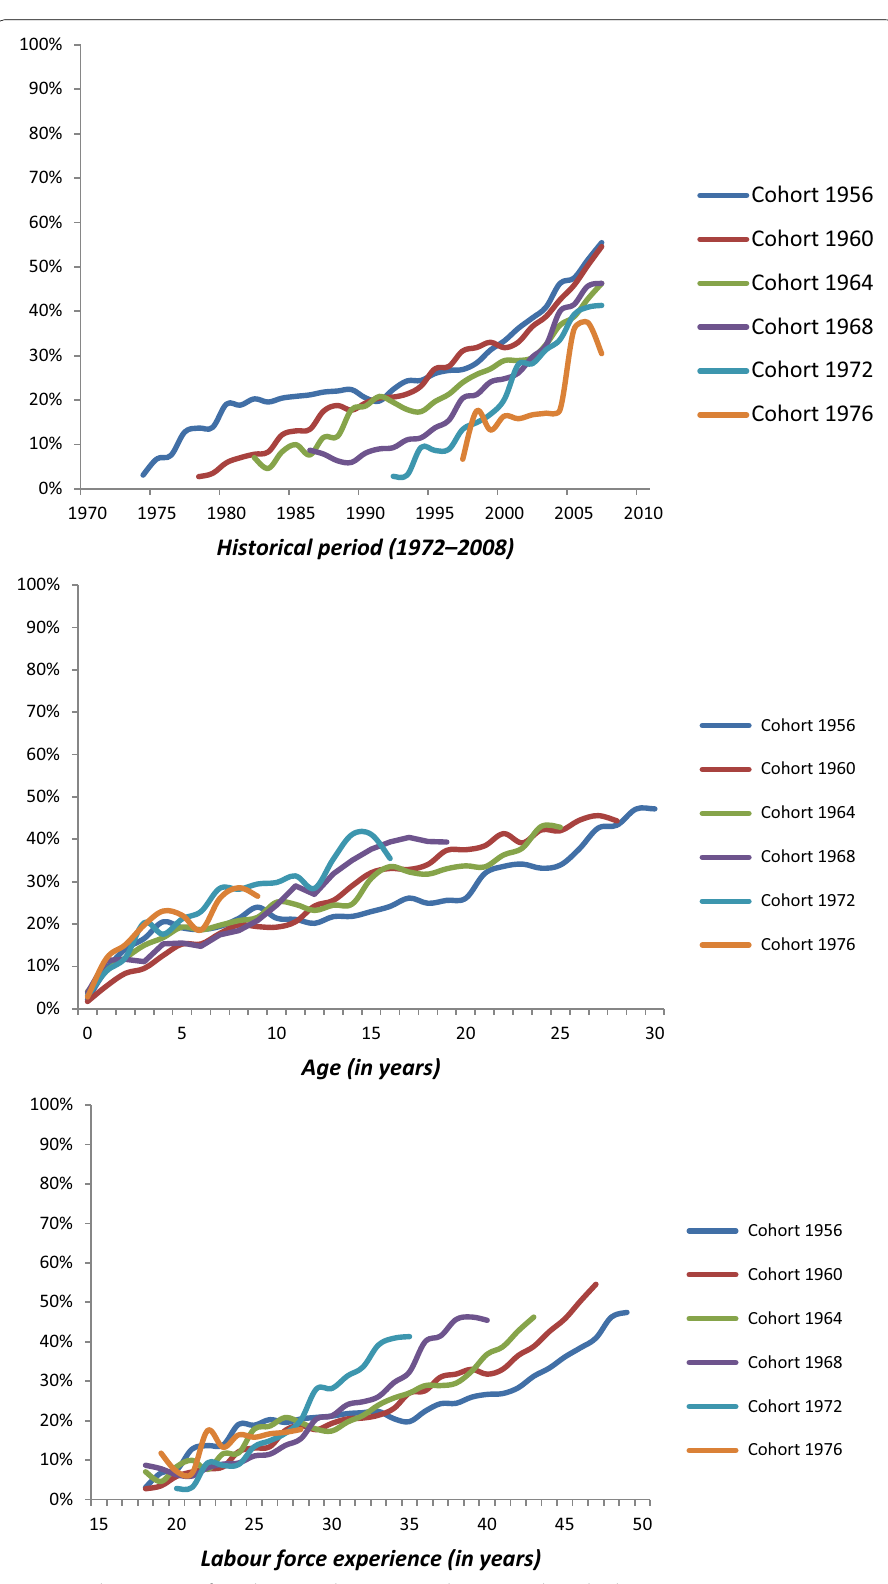
Fig. 2 Further training of employees in their vocational career—selected